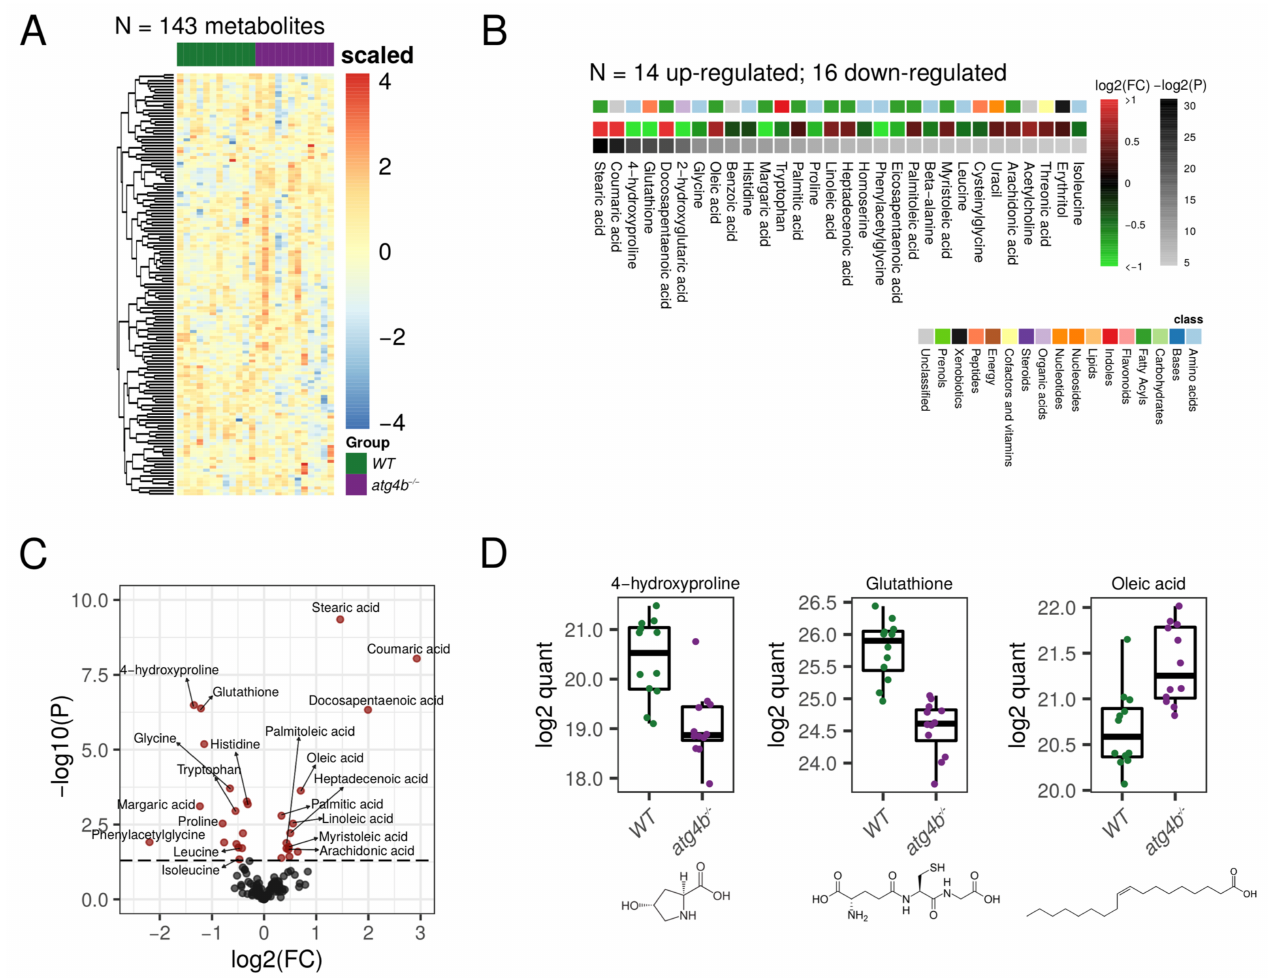
Figure 2. Autophagy deficiency upon ATG4B loss in skeletal muscle. ( A ) Heatmap showing the row-scaled log2 quantifi- cation levels of all the profiled metabolites in skeletal muscle tissue samples. ( B ) Heatmap describing the change (log2 of fold change) of the metabolites with significantly altered levels between WT and atg4b − / − samples. ( C ) Volcano plot comparing the effect size (log2 of fold change) to the significance ( − log10 of p -value) of the metabolites altered between WT and atg4b − / − samples. Significant metabolites are colored in red. Representative metabolites are labeled within the plot. ( D ) Boxplots showing the log2 quantification levels of three representative metabolites, which are significantly altered between WT and atg4b − / − samples. Significance is defined as an unadjusted p -value <